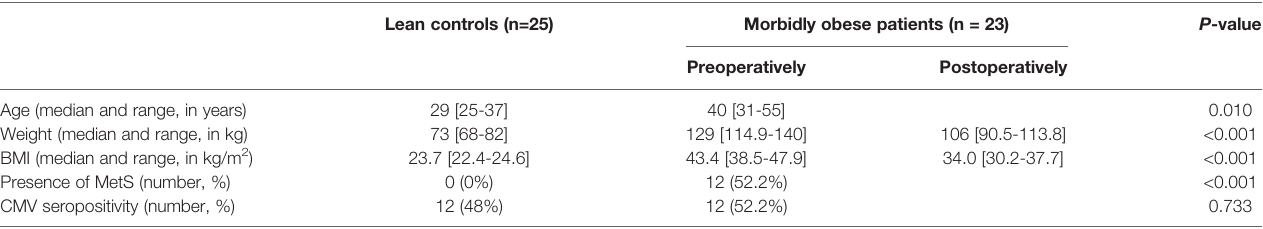
TABLE 1 | Study population